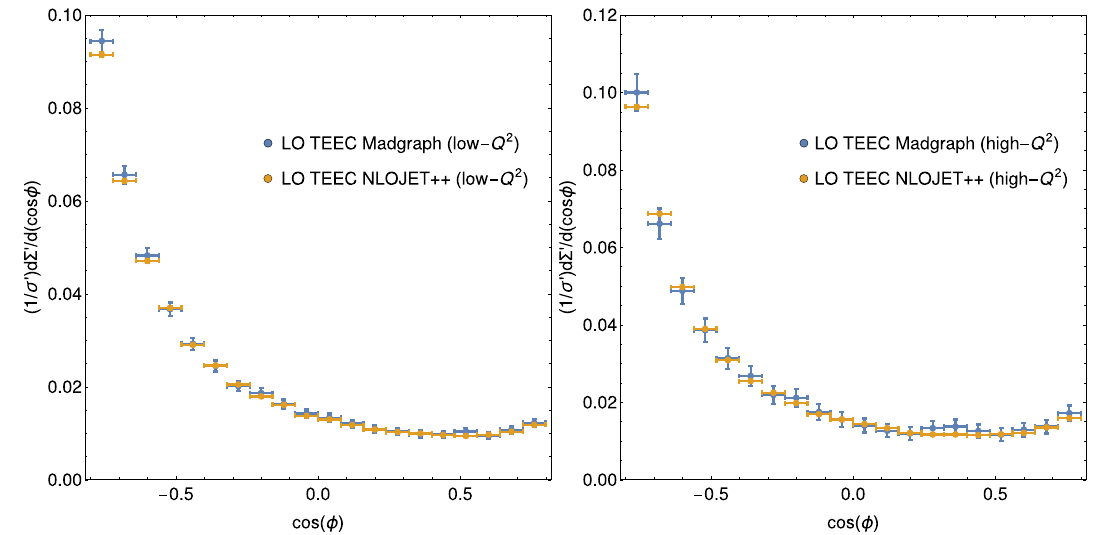
Fig. 11 Comparison of the LO differential distribution 1 /σ (cid:7) d (cid:9) (cid:7) / d ( cos φ) obtained using Madgraph and NLOJET++ in the low- Q 2 range (left frame) and the high- Q 2 range (right